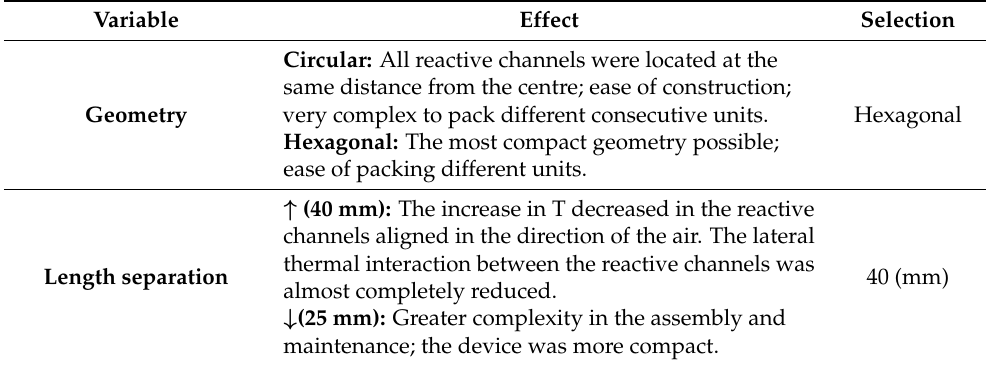
Table 5. The effect of each variable on the performance of the scaled-up multi-tubular fixed-bed reactor designs simulated for the CO 2 methanation